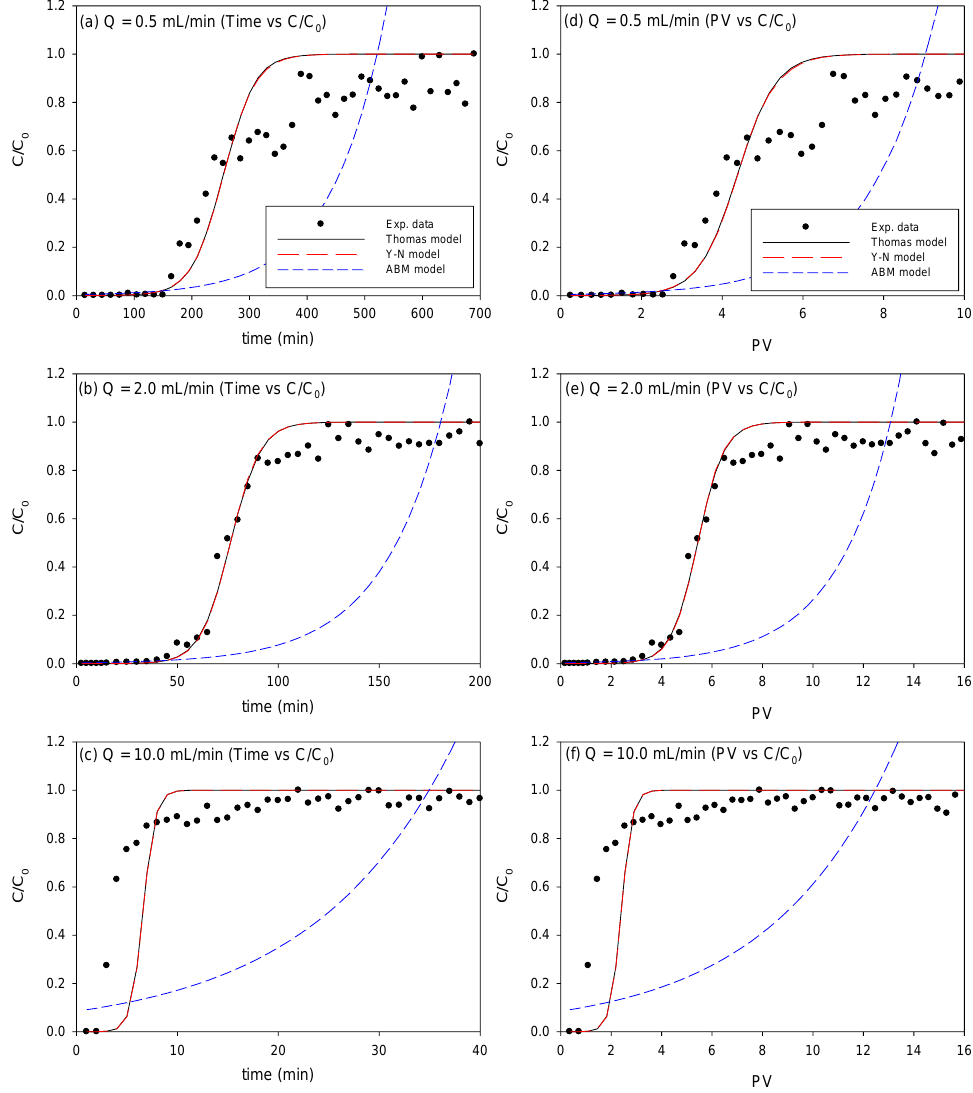
Figure 9. The effect of flow rate on the As adsorption breakthrough curves: ( a – c ) C/C 0 vs. time and ( d – f ) C/C 0 vs PV. Table 2. Parameters of Thomas, Yoon-Nelson, and Adams-Bohart models for As column.